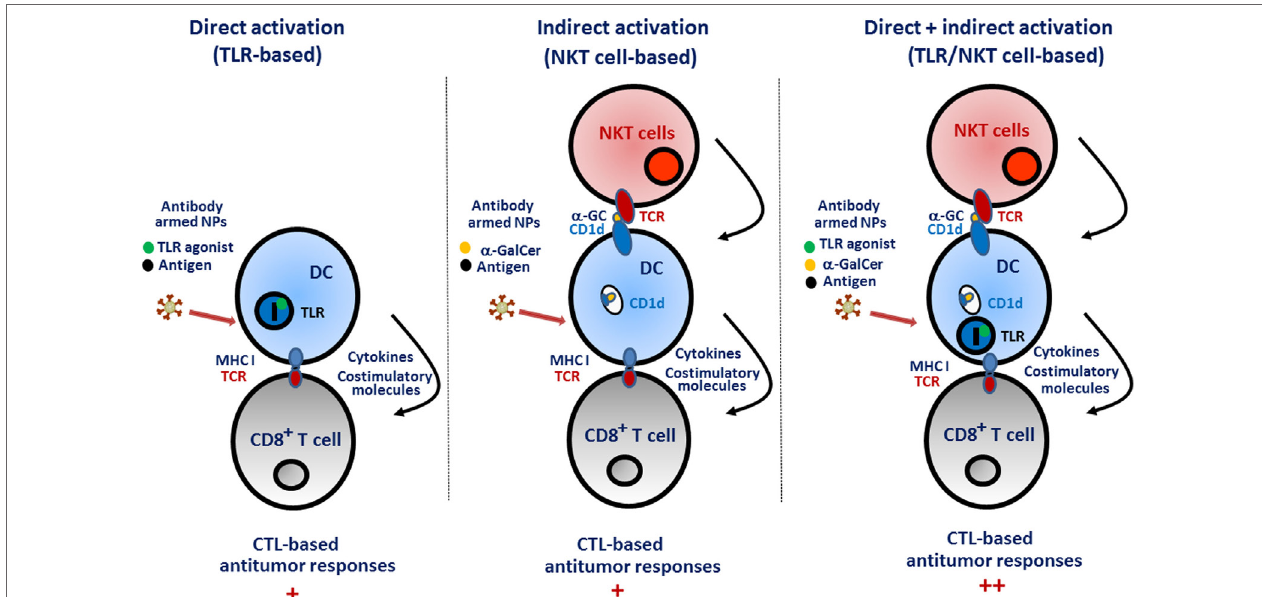
FiGURe 2 | Promotion of CD8 + T cell responses upon direct [toll-like receptor (TLR)-based] and/or indirect [natural killer T (NKT) cell based] dendritic cell (DC) activation. Direct activation. Nanoparticles bearing TLR agonists are internalized by DCs (i.e., those that excel in cross-presentation) and activate endosomal TLRs (such as TLR3, TLR7/8, or TLR9). This rapidly leads to DC maturation and to the production of inflammatory cytokines and costimulatory molecules that in turn promote the differentiation and expansion of naïve CD8 + T cells. Indirect activation. In this setting, the delivery of α -GalCer in DCs leads to the exposition of the glycolipid on the cell surface in association with the CD1d molecule (at this stage, the DC is still immature). TCR triggering in NKT cells leads to the release of cytokines and to the expression of costimulatory (CD40) molecules culminating in DC maturation. In turn, mature DCs activate naïve CD8 + T cells. Direct and indirect activation. One may suppose that the two effects are additive, or even synergistic, to promote optimal CD8 + T cell responses that control tumor progression.